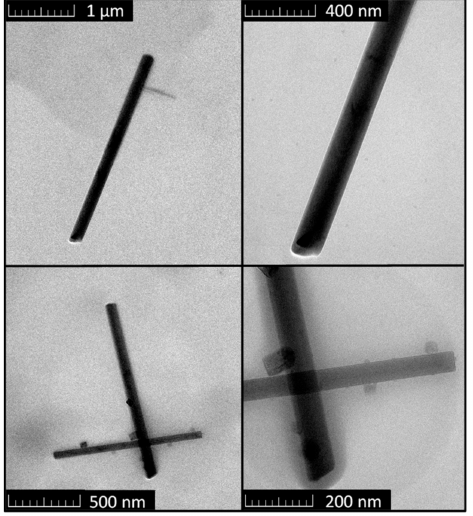
Figure 5. Micrographs obtained by transmission electron microscopy of MOC